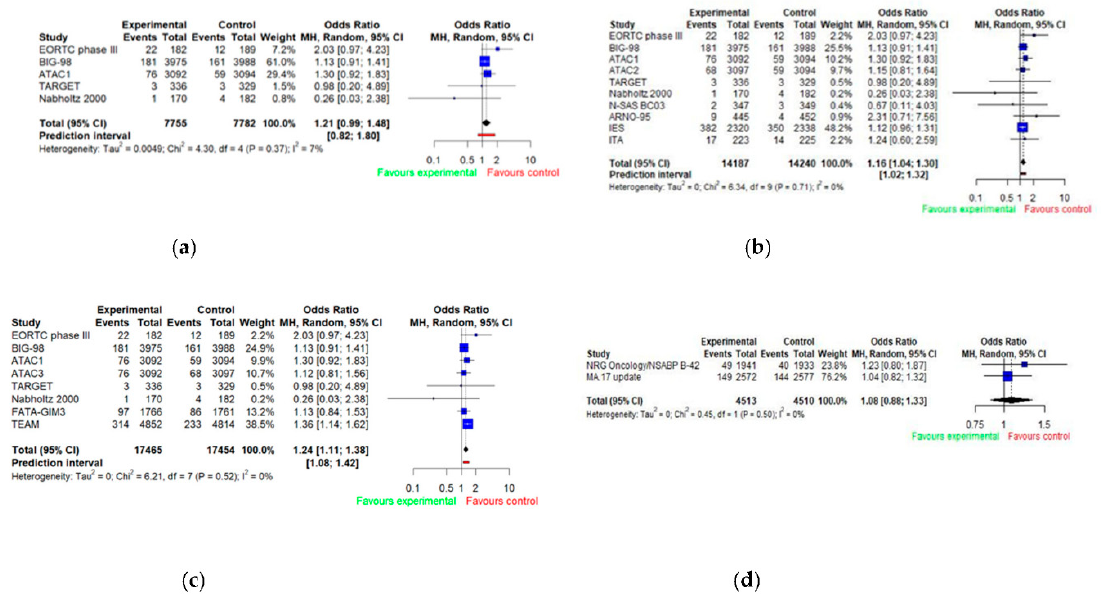
Figure 3. Forest plot of odds ratios for cardiovascular events with AIs by trial design ( a – d ). E (experimental group); C (control group). ( a ) E: AIs vs. C: tamoxifen (monotherapy); ( b ) E: AIs (monotherapy) or AIs + tamoxifen (sequence) vs. C: tamoxifen (monotherapy); ( c ) E: AIs (monotherapy) vs. C: AIs + tamoxifen (sequence) or tamoxifen (monotherapy); ( d ) E: AIs (monotherapy) vs. C: placebo/no treatment.